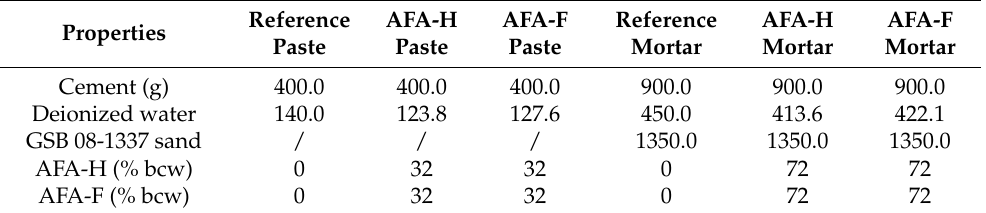
Table 3. Cement paste and mortar compositions for each accelerator and environment